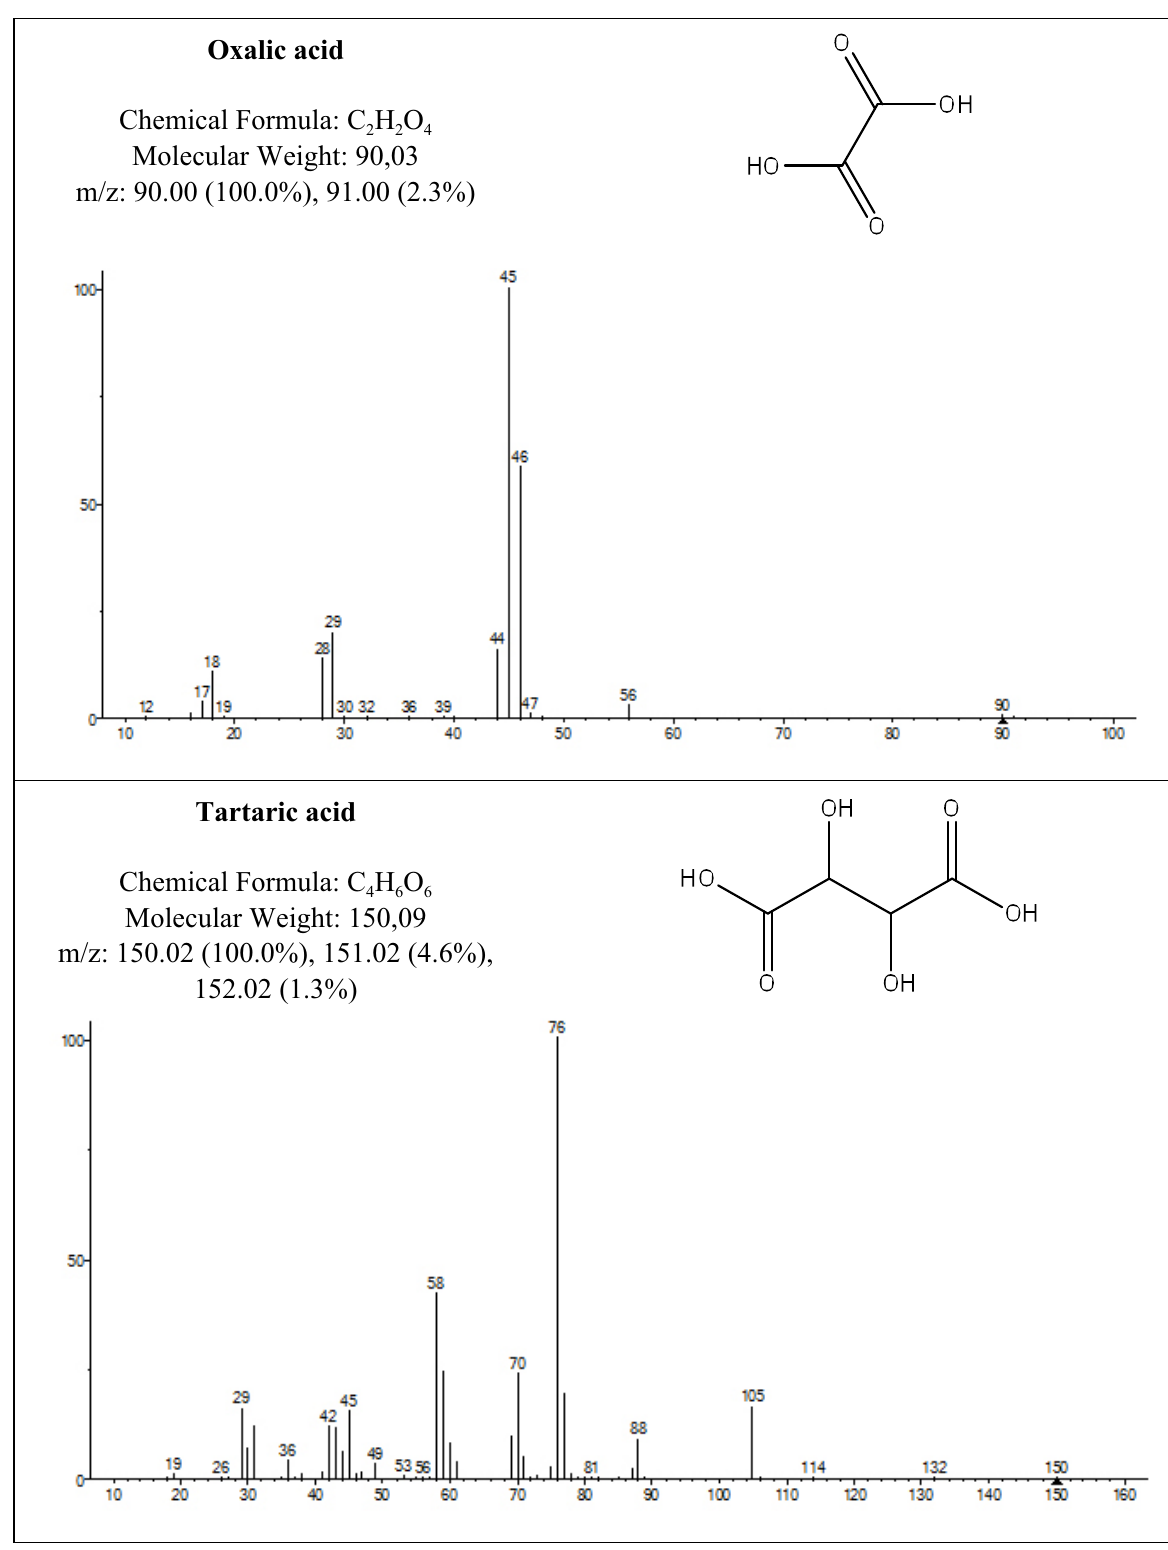
Fig. S1: Mass spectrometry data of some selected phytochemicals in B. ramiflora decoctions and